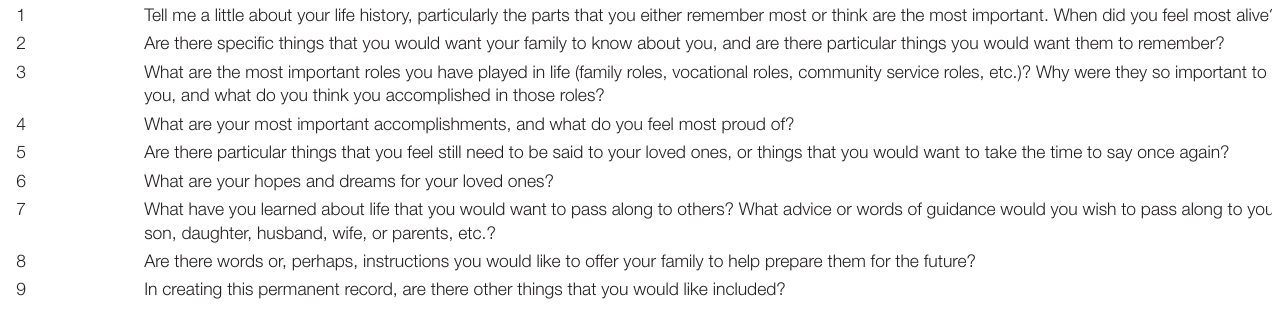
TABLE 1 | Dignity therapy question